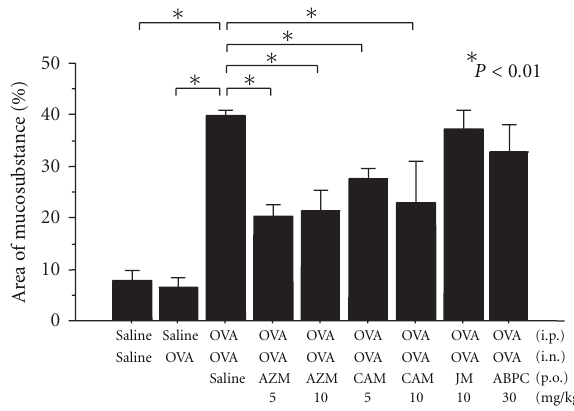
Figure 1: E ff ects of azithromycin (AZM, 5–10 mg/kg), clarithromy- cin (CAM, 5–10mg/kg), josamycin (JM, 10 mg/kg), or ampicillin (ABPC, 30 mg/kg) on OVA-induced mucus production in OVA- sensitized rats ( n = 6). Significant increase in intraepithelial muco- substance occurred 24 hours after 3 days of OVA instillation. Oral administration of AZM or CAM significantly inhibited antigen- induced mucus production, whereas JM and ABPC had no e ff ect.